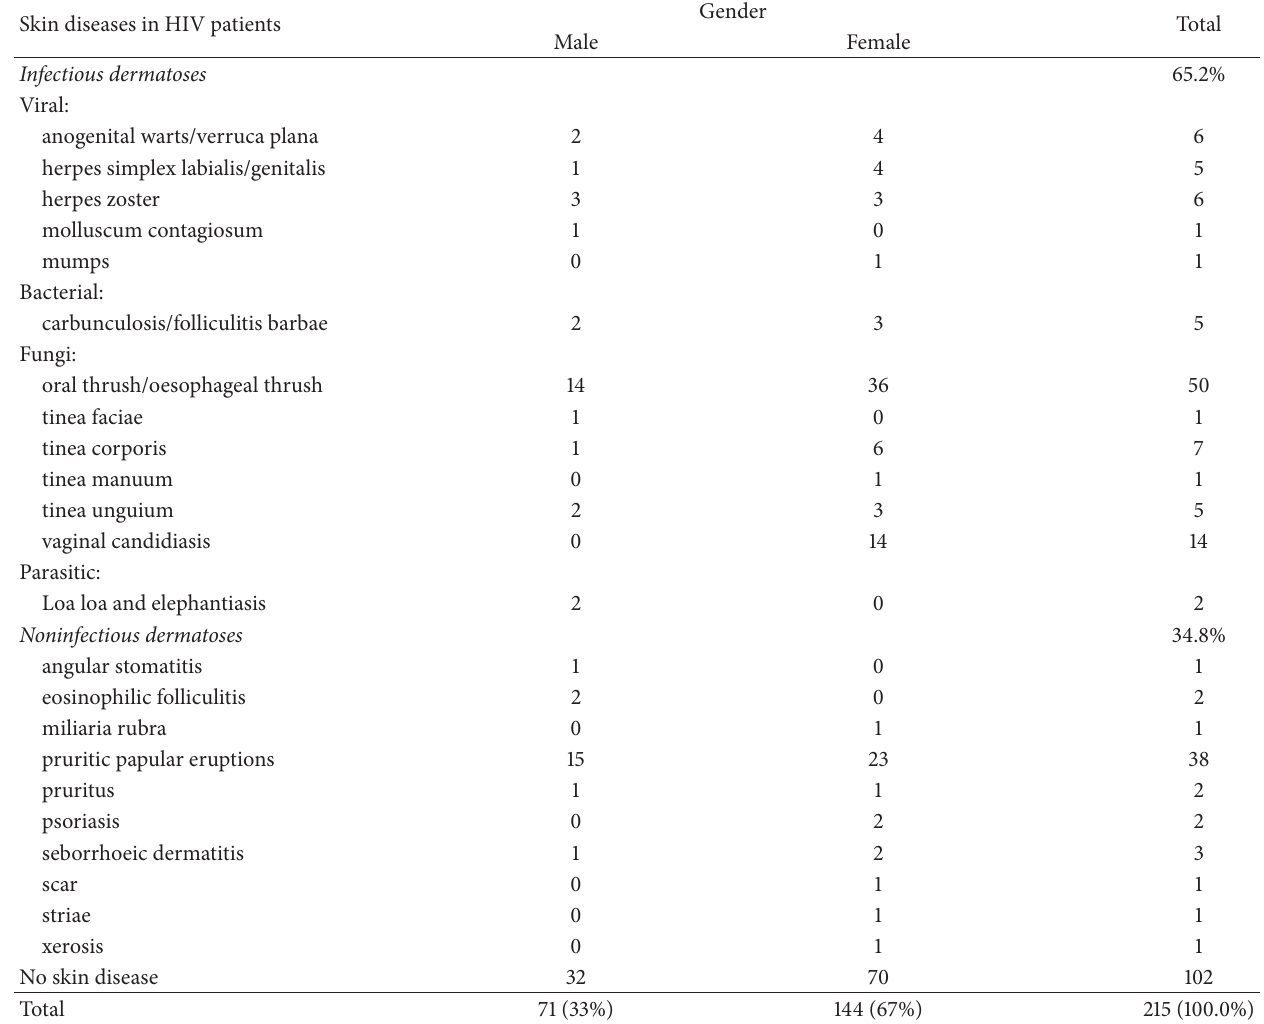
Table 1: Skin diseases in HIV patients according to